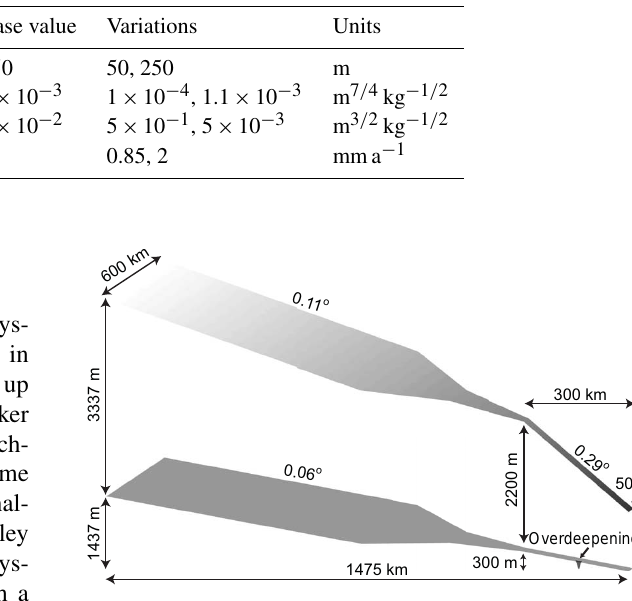
Figure 1. Model domain designed to emulate the catchment of Re- covery Ice Stream. The overdeepening has a depth of 150m. The slopes of the planar surfaces are noted with a steeper surface slope in the narrow ice stream portion of the